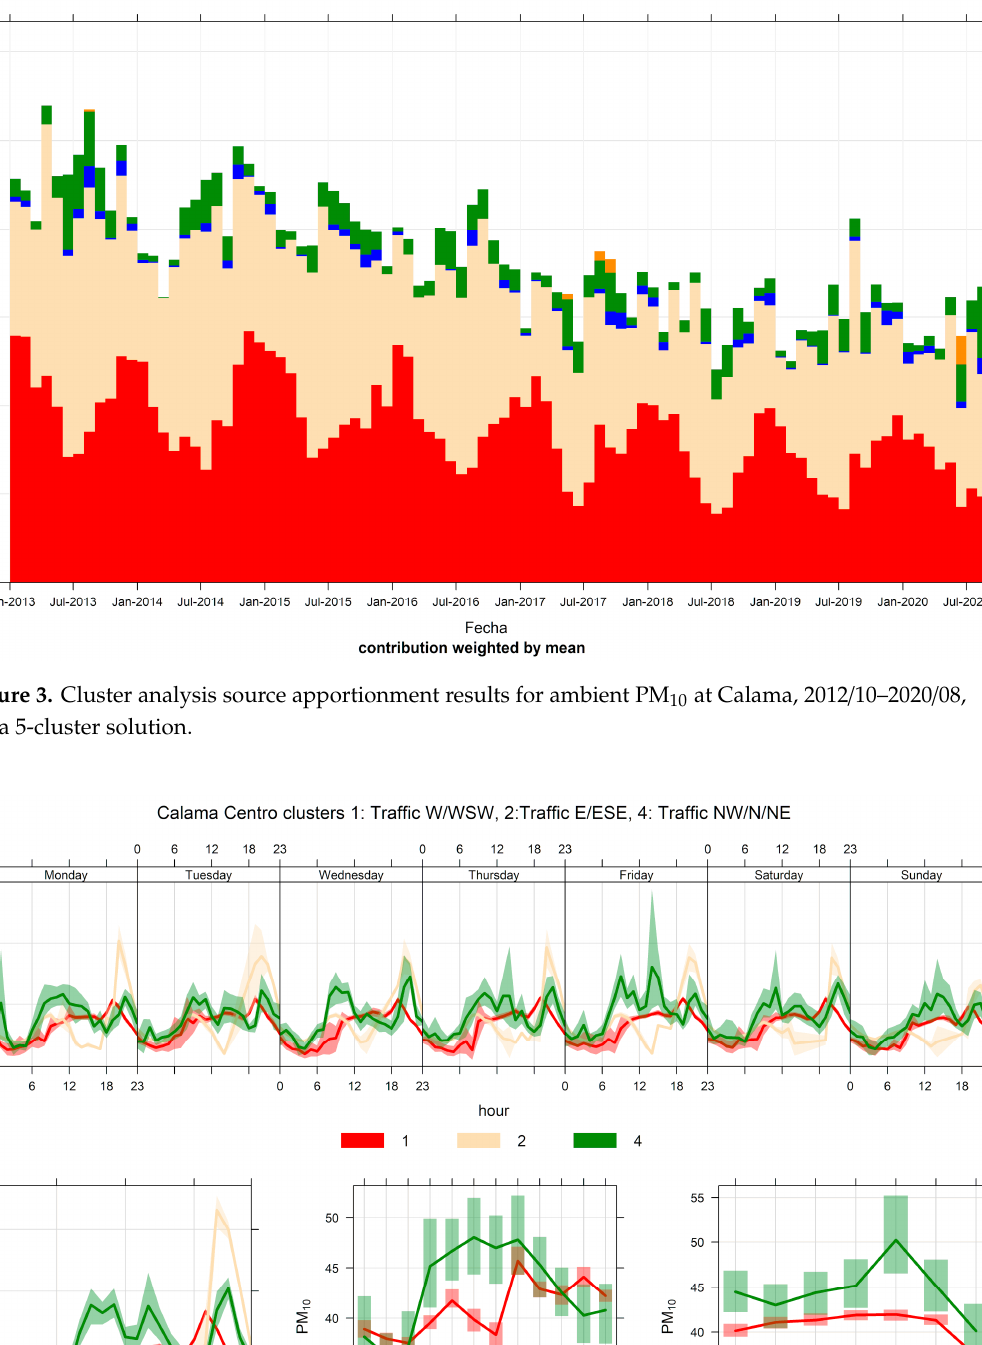
Figure 5. Time variation plot for cluster analysis source apportionment results for ambient NOx at Calama, 2012/10–2020/08, for a five-cluster solution. Only clusters 1, 2, and 4 are plotted for clarity’s sake.